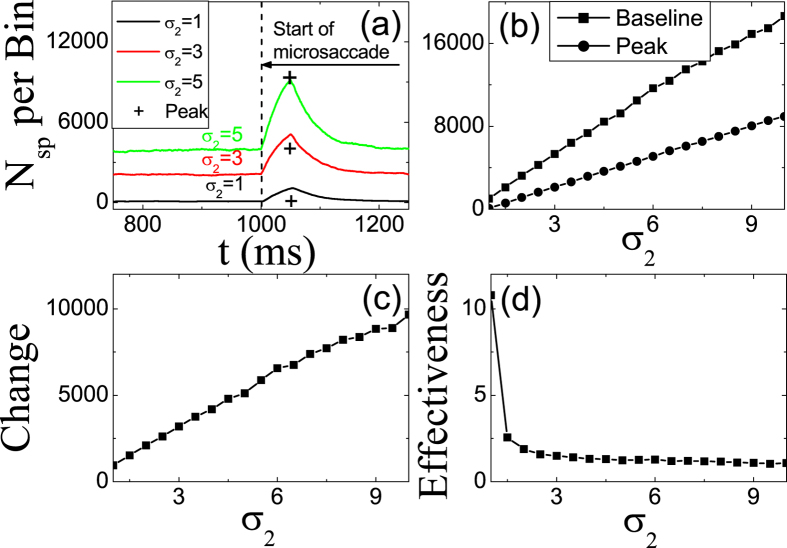
The same as in Fig. 2, but for different σ2.The parameters are g = 0.2, A = 100, ΔM = 2.0 and σ1 = 1.5.